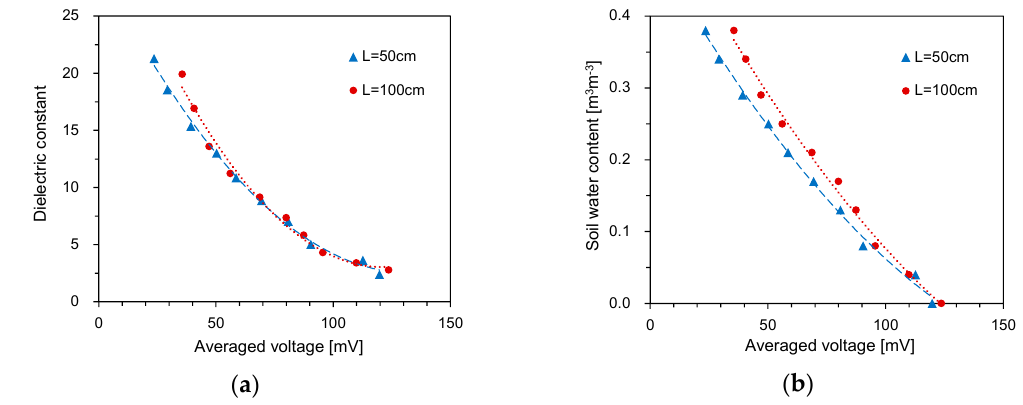
Figure 12. Relationships between average amplitude and: (a) dielectric constant; (b) SWC.